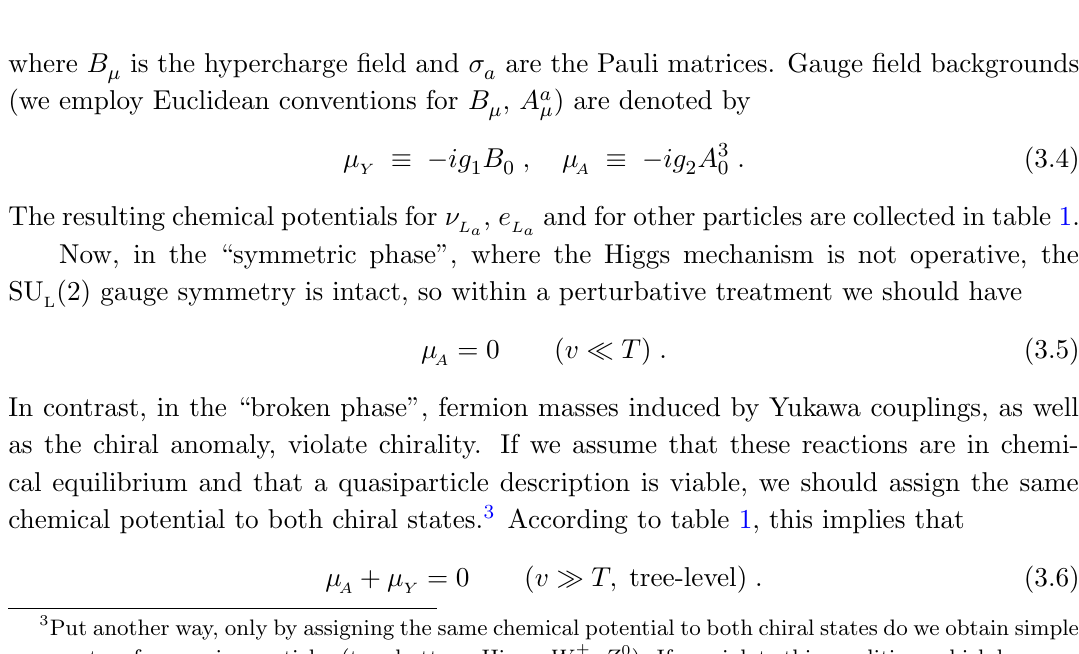
Table 1 . E(cid:11)ective chemical potentials carried by Standard Model particles in the chiral limit, obtained from eq. (3.1) (we denote (cid:22) q (cid:17) (cid:22) = 3) and from covariant derivatives after the use of B eq. (3.4). In the symmetric phase v (cid:28) T , we impose eq. (3.5), so only (cid:22) plays a role. Deep in Y the broken phase v (cid:29) T , when fermion masses and the chiral anomaly lead to rapid transitions between the two chiral states, we impose eq. (3.6), guaranteeing that both chiral states have the same chemical potential. The same applies to Goldstone modes and the corresponding gauge (cid:12)elds. The intermediate regime v (cid:24) T is more delicate and the assignments above are only suggestive (cf. the text). No chemical potential is indicated for right-handed neutrinos, which are not necessarily in chemical